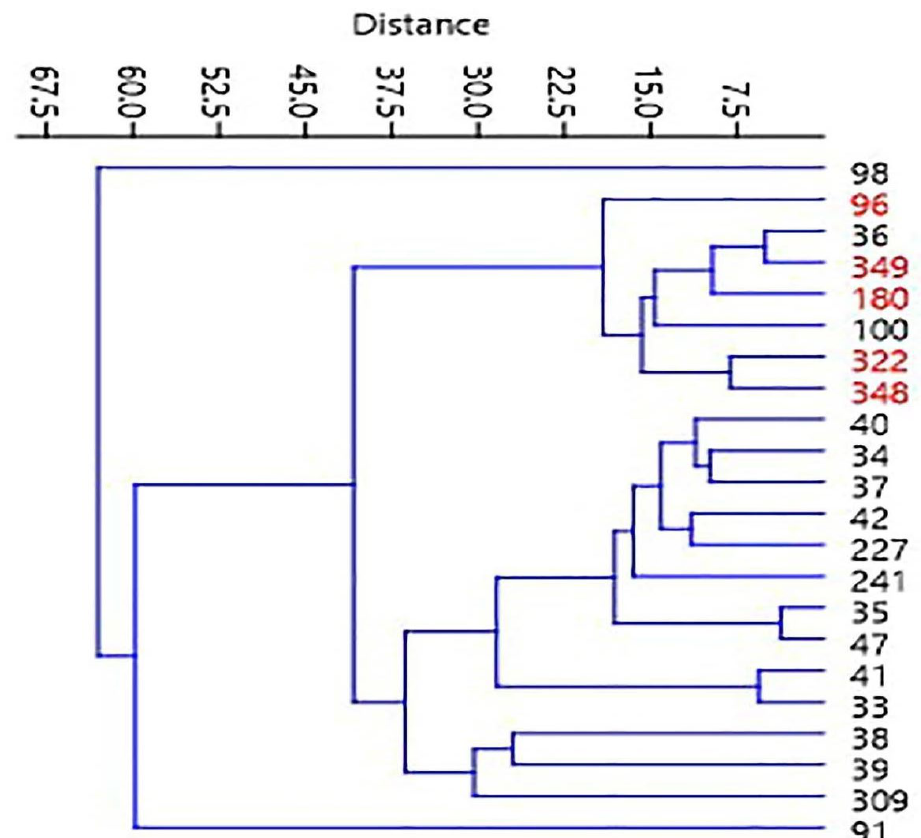
Figure 12. Hierarchical Clustering of basalt (black) and quartz (red) cores using principal components scores and computing a Euclidean